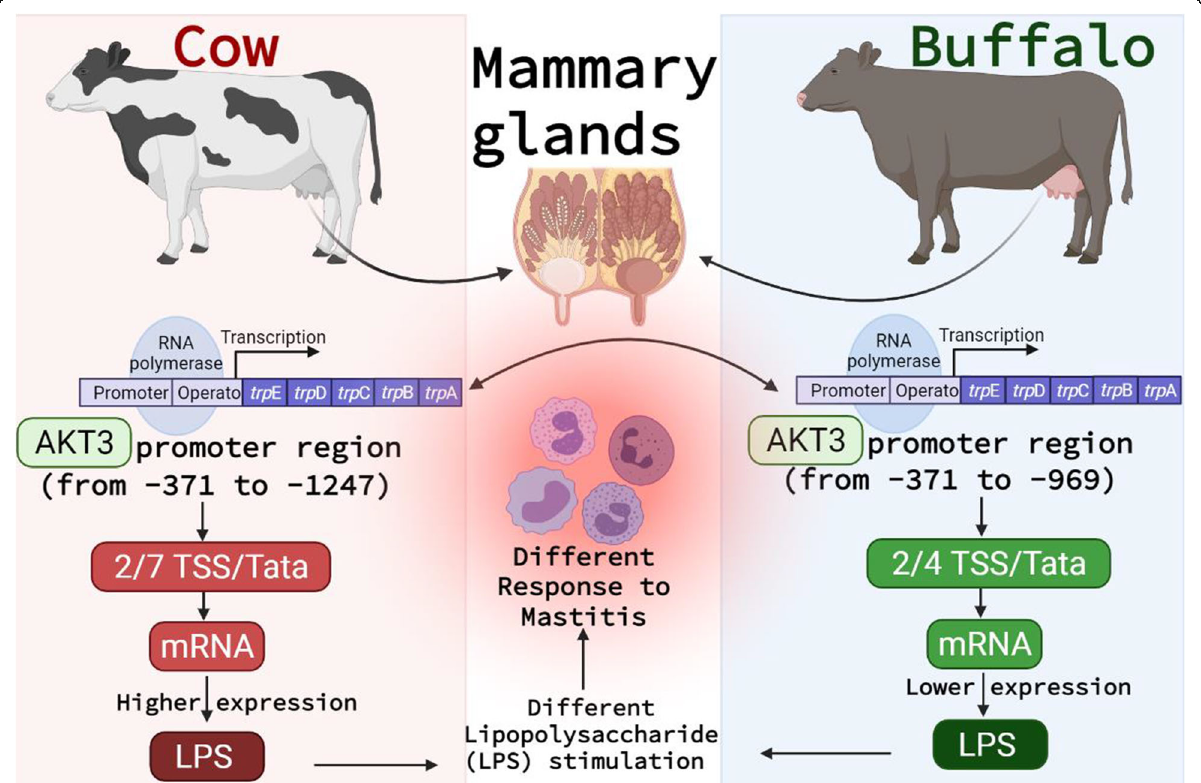
Fig. 7 The different responses to mastitis between cow and buffalo based on the differences in AKT3 gene promoters